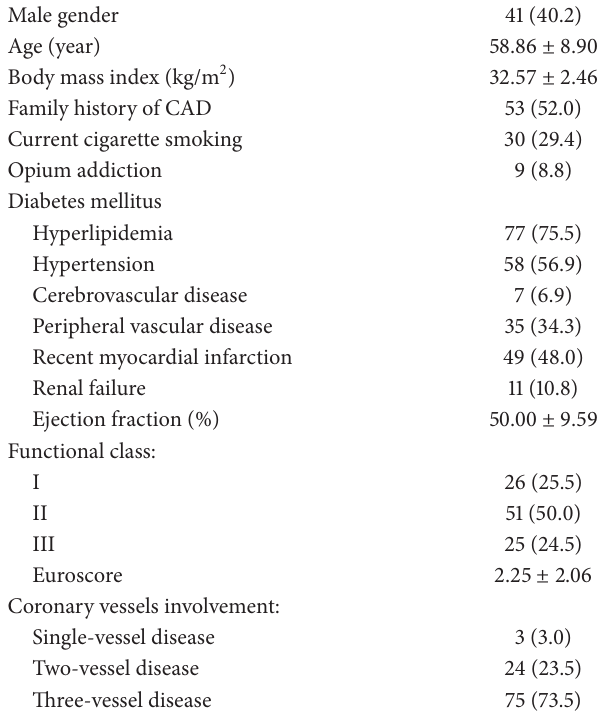
Table 2: Demographic characteristics and clinical data of studied patients ( 𝑛 = 102